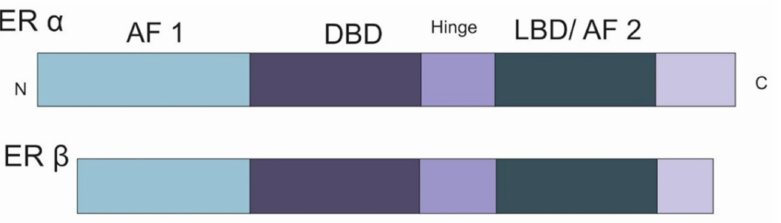
Figure 1. Schematic presentation of the arrangement of domains in estrogen receptors (ER) alpha and beta. N: Amino Terminal, C: Carboxyl Terminal, AF: Activation Function, DBD: DNA binding Domain, LBD: Ligand binding Domain, adapted from